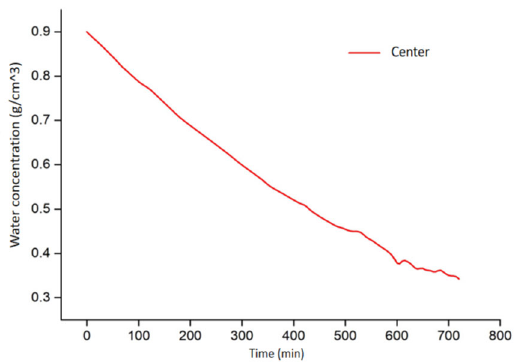
Figure 9. Water concentration at the center of potato samples during RF drying.